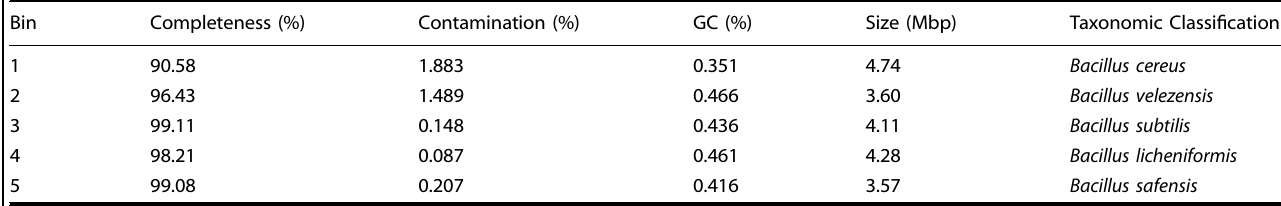
Completeness and contamination statistics were determined using the CheckM